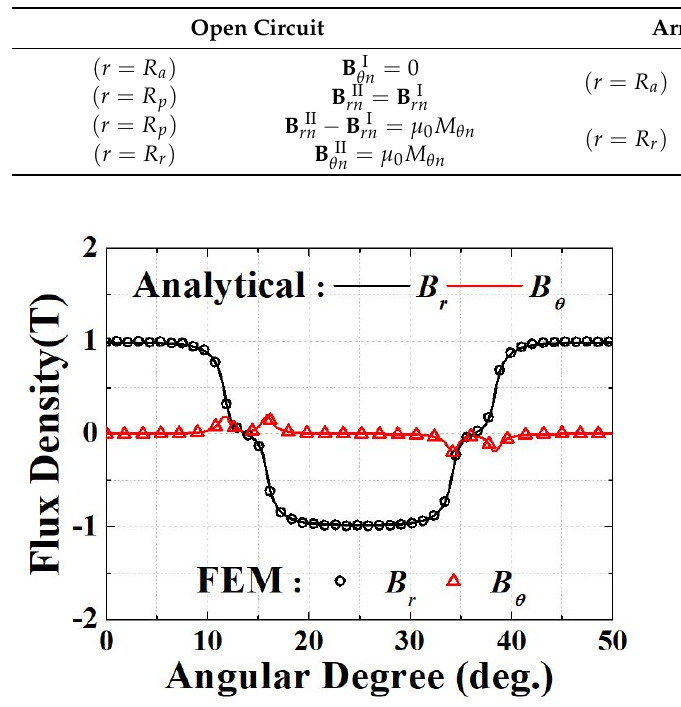
Figure 6. Comparison of open circuit magnetic field characteristics.